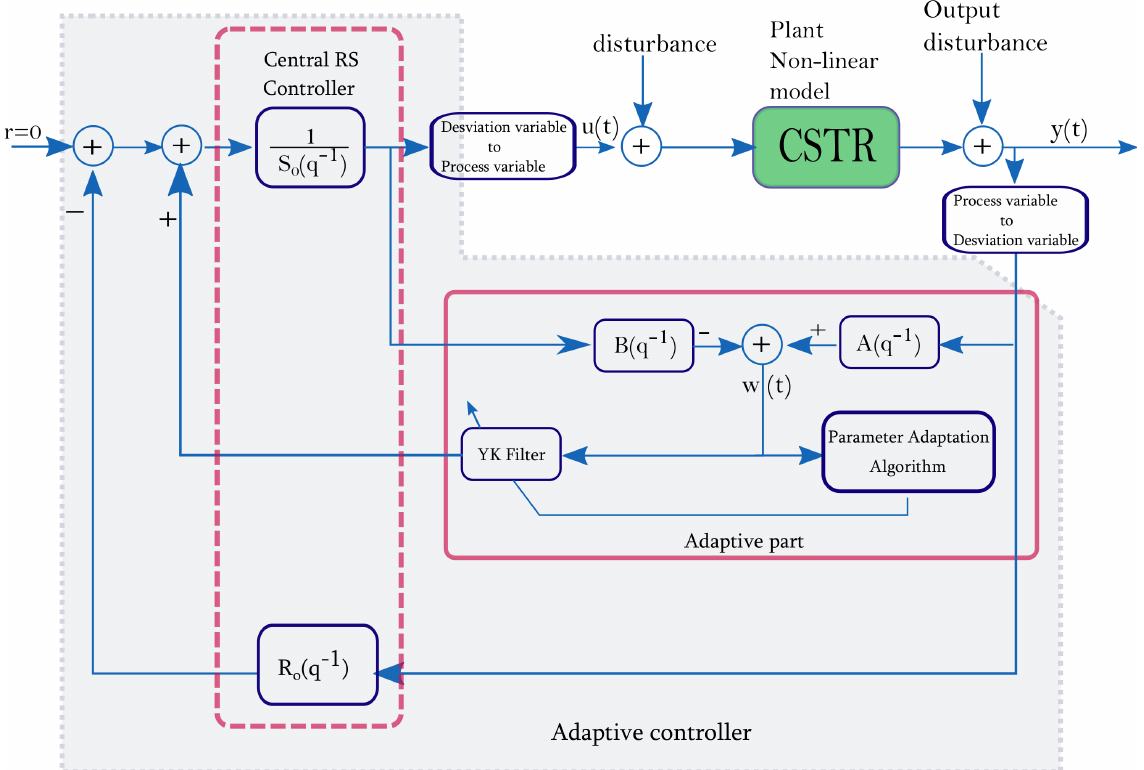
Figure 4. Adaptive control scheme for a